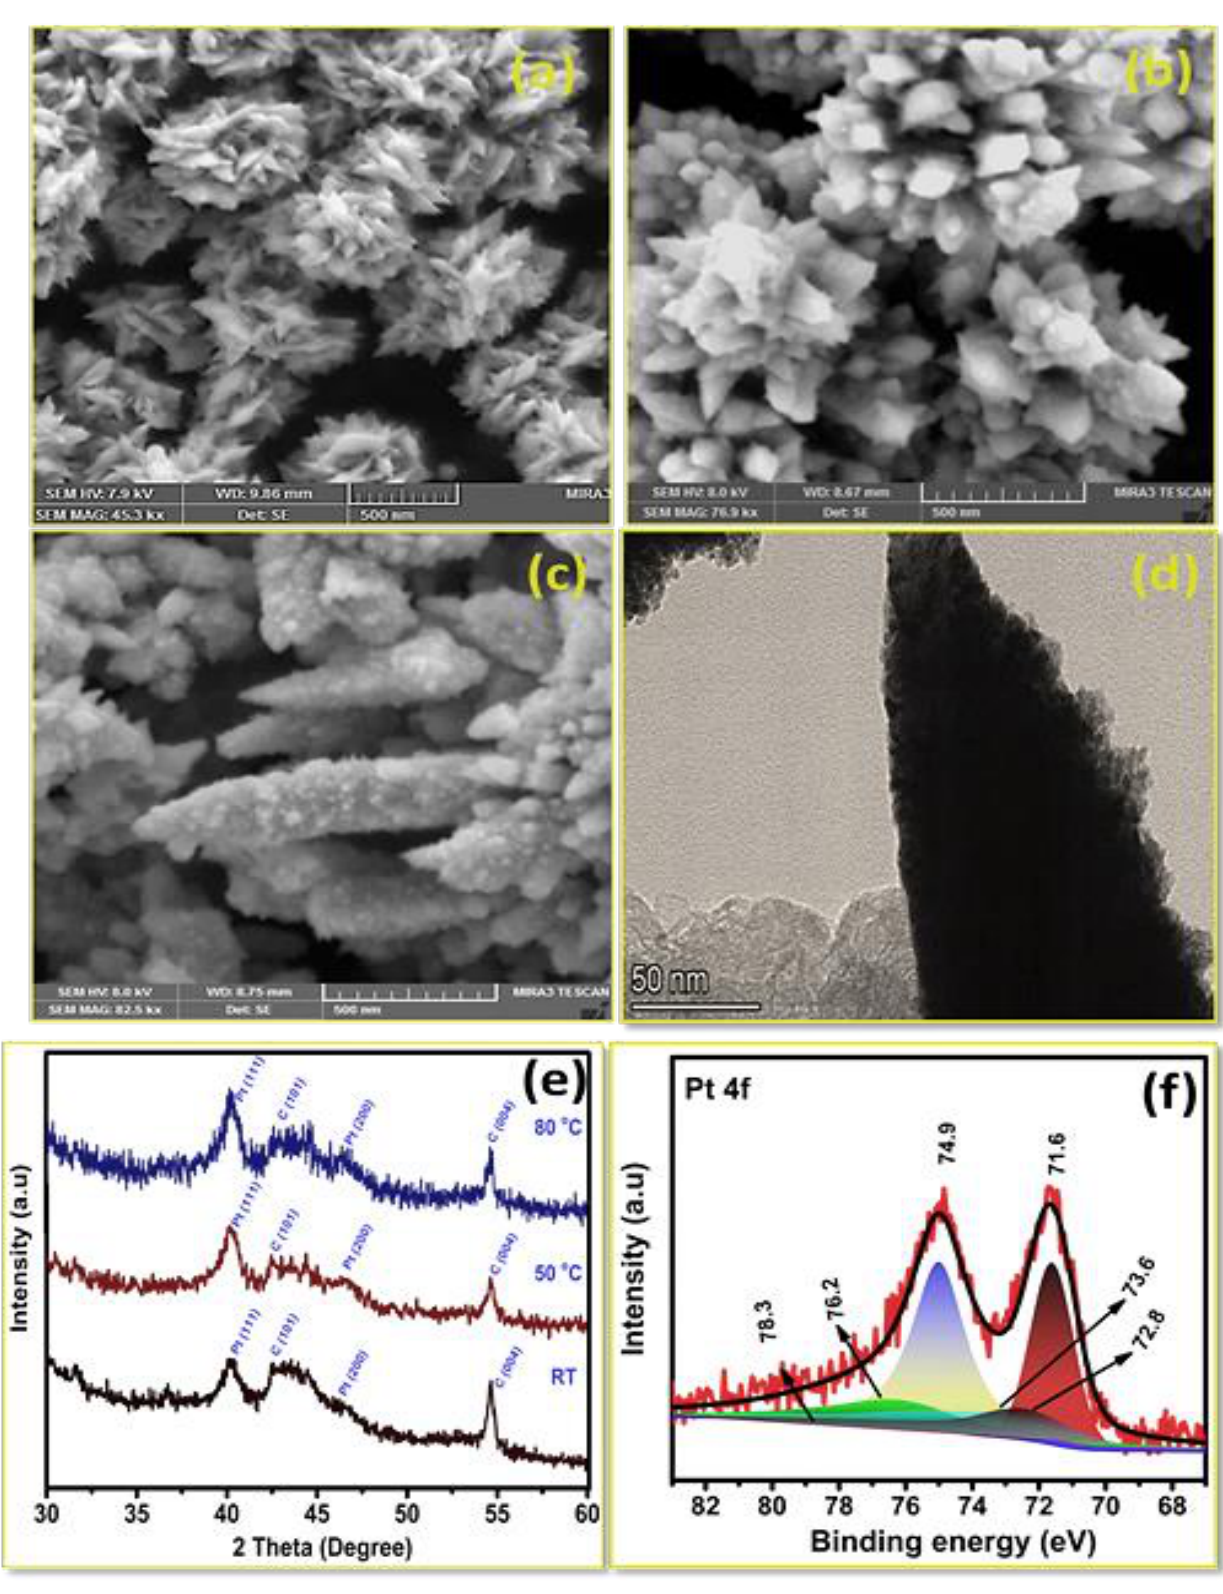
Figure 4. FE-SEM micrographs of Pt deposited on carbon substrate with effect of bath temperature; ( a ) room temperature, ( b ) 50 °C, ( c ) 80 °C, ( d ) HR-TEM image of Pt deposition (80 °C), ( e ) XRD pattern, and ( f ) XPS Pt 4f spectrum of Pt deposition at (80 °C).